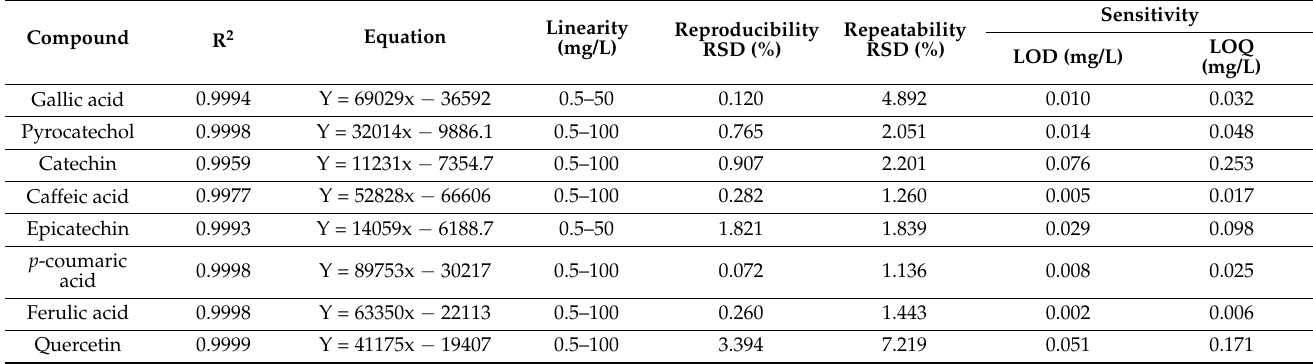
Table 5. Analytical parameters and calibration data for phenolic compounds.